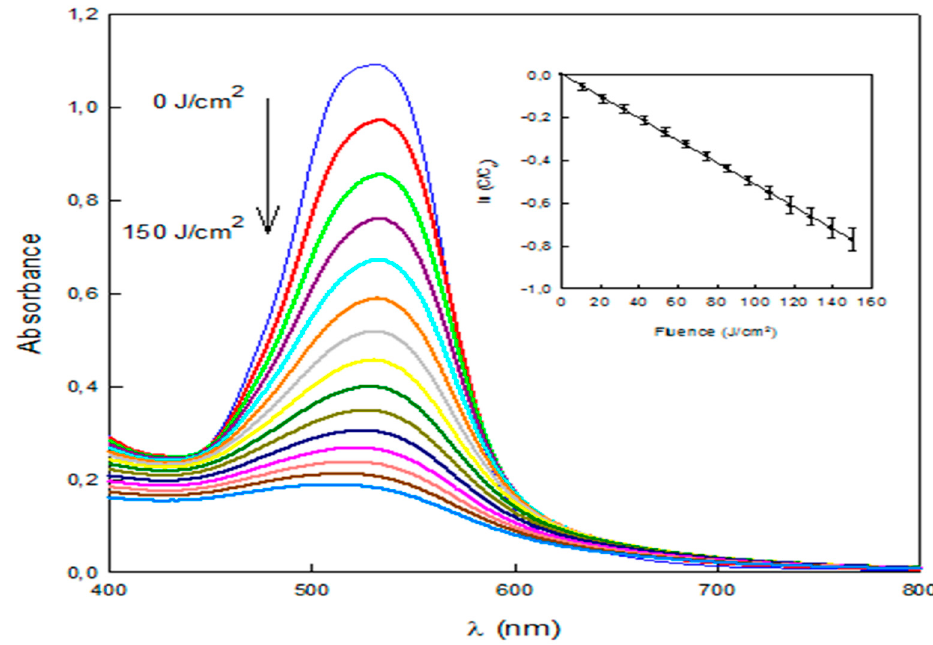
Figure 9. Spectral changes during the course of the degradation of Direct Red 83:1 by a pulsed light/H 2 O 2 advanced oxidation process. Inset: Pseudo-first order kinetic plot.